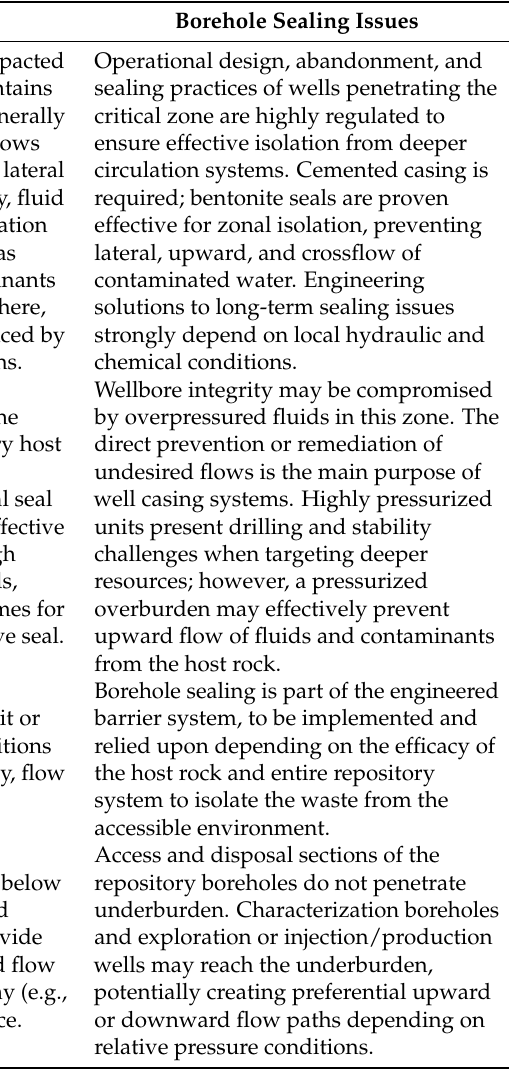
Table 2. Main geological zones and associated borehole sealing